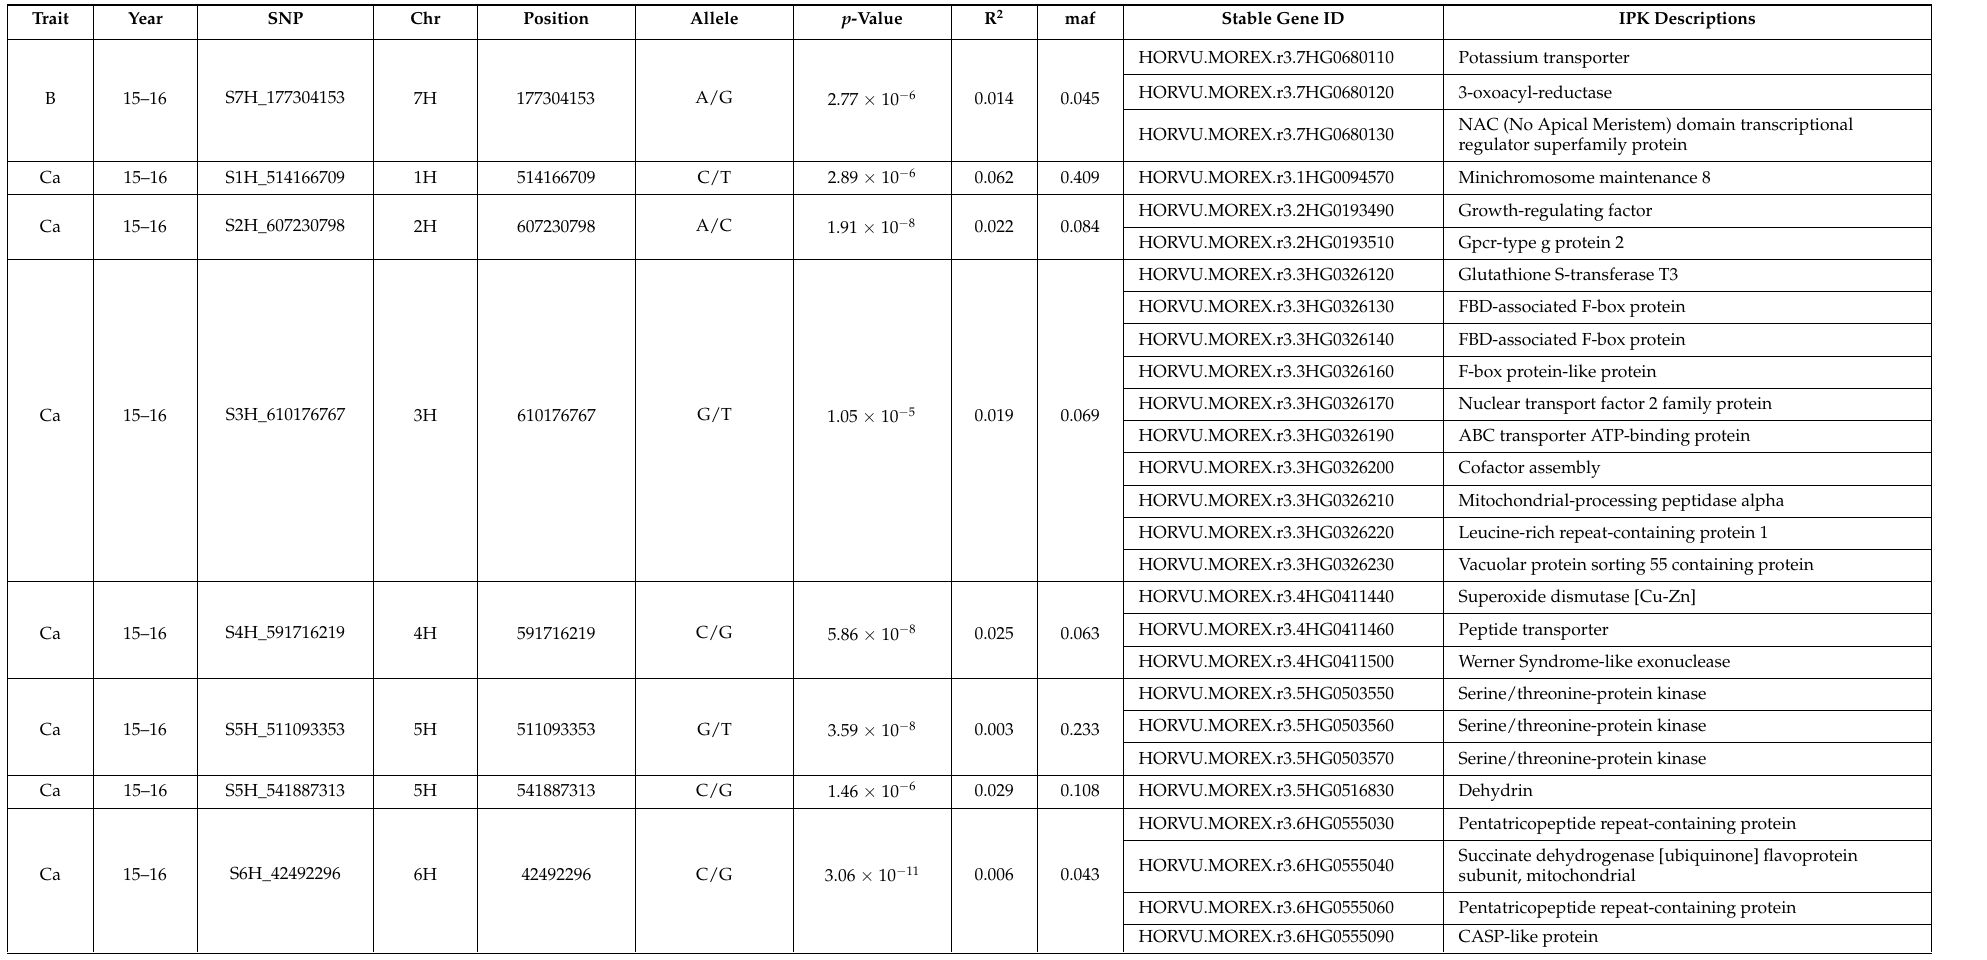
Table 2. SNPs Associated with Seed Micronutrients and Genes of Interest in that Genomic